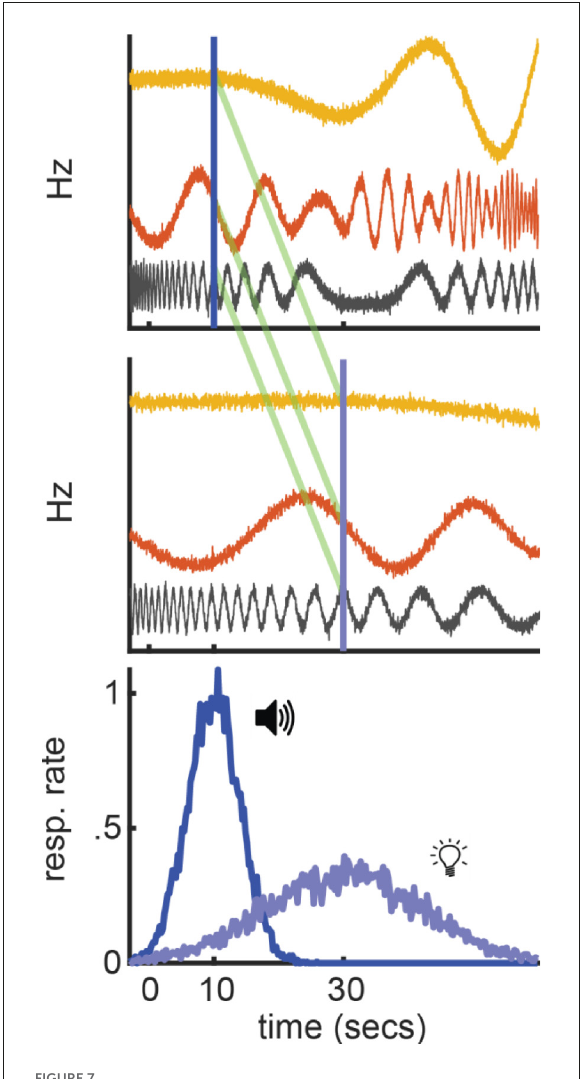
FIGURE7 Hypothetical relative population-clock model. Top and middle: Hypothetical population activity that rescales when timing a short or long interval, respectively. Green lines highlight the same population pattern guides both intervals. Bottom: How this model would correspond to behavior during a peak-interval procedurewhereatoneandlightareassociatedwith10and30s,